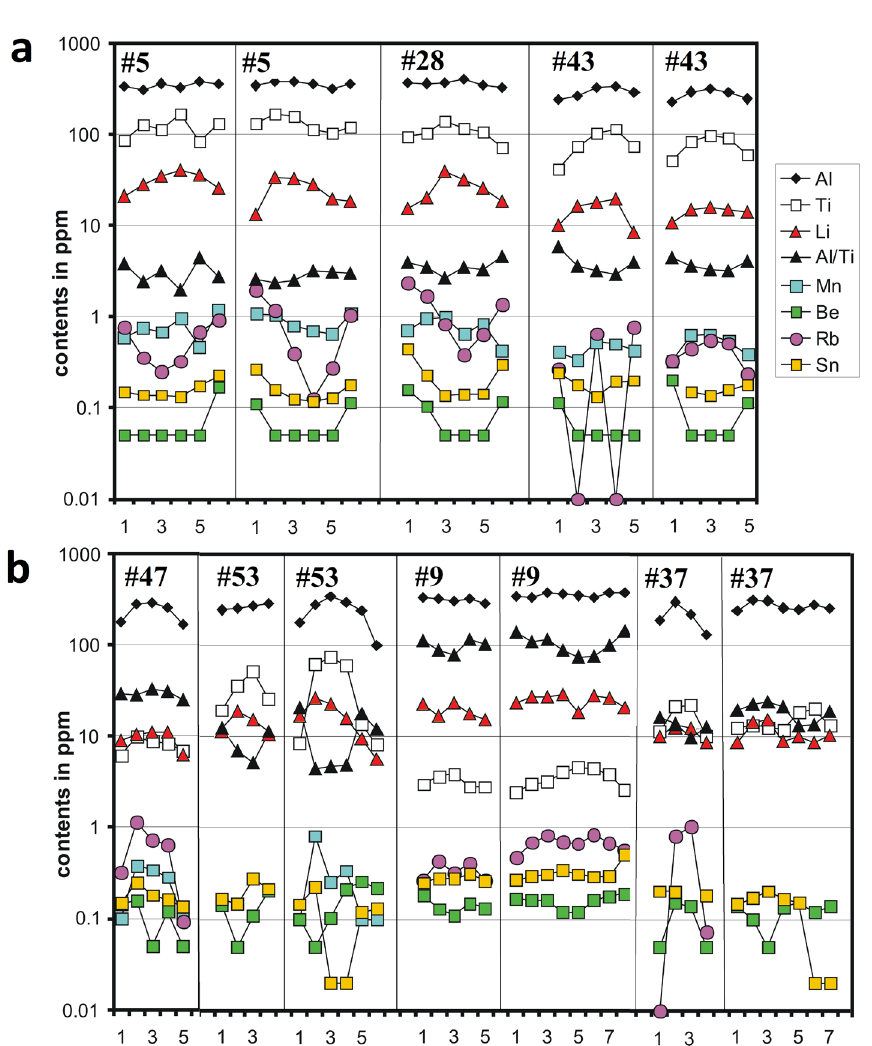
Figure 7. Chemical compositions along profiles across selected quartz grains: ( a ) porphyritic granite (samples Nos. 5, 28, 43); ( b ) leucogranite (samples Nos. 47, 53) and greisenized granite (Nos. 9, 37). Table 3. Contents of trace elements in typical quartz crystals in ppm (LA-ICP- MS data). Empty cell—below detection limit.